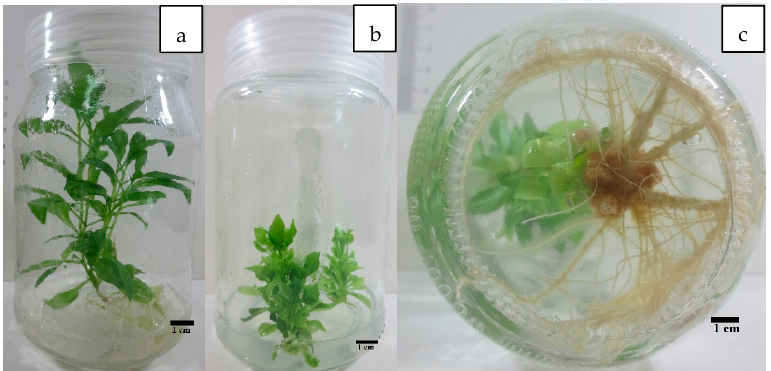
Figure 1. In vitro plant micropropagation protocol of L. schweinfurthii : ( a ) aseptic seedling; ( b ) shoot formation after five weeks of culture on MS medium supplemented with 0.4 mg L − 1 Kinetin; ( c ) roots formed on MS medium fortified with 0.4 mg L − 1 IBA (indole-3-butyric acid).